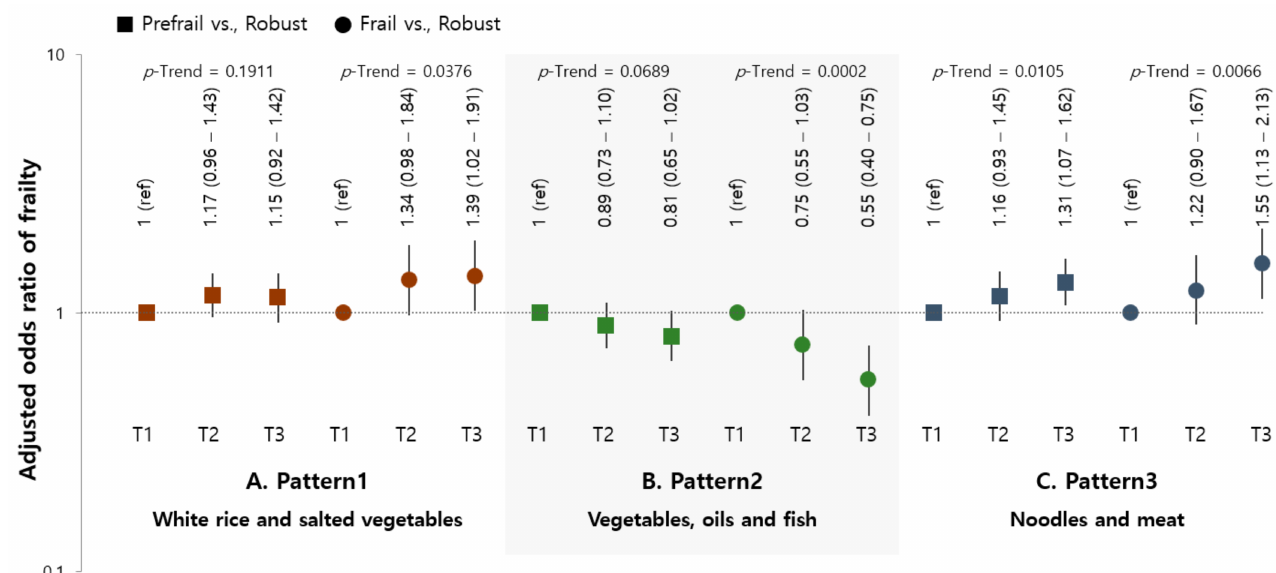
Figure 2. Adjusted ORs (95% CI) for pre-frailty and frailty according to the tertile of dietary pattern scores. ( A ) “White rice and salted vegetables”; ( B ) “Vegetables, oils, and fish”; ( C ) “Noodles and meat.” Ref.: reference category; OR: odds ratio; CI: confidence interval. Data were calculated using the multinomial SURVEYLOGISTIC model. ORs (95% CIs) were adjusted for gender, age, BMI, living status, residential area, family income, education level, smoking status, high-risk alcohol consumption, comorbidity, and energy